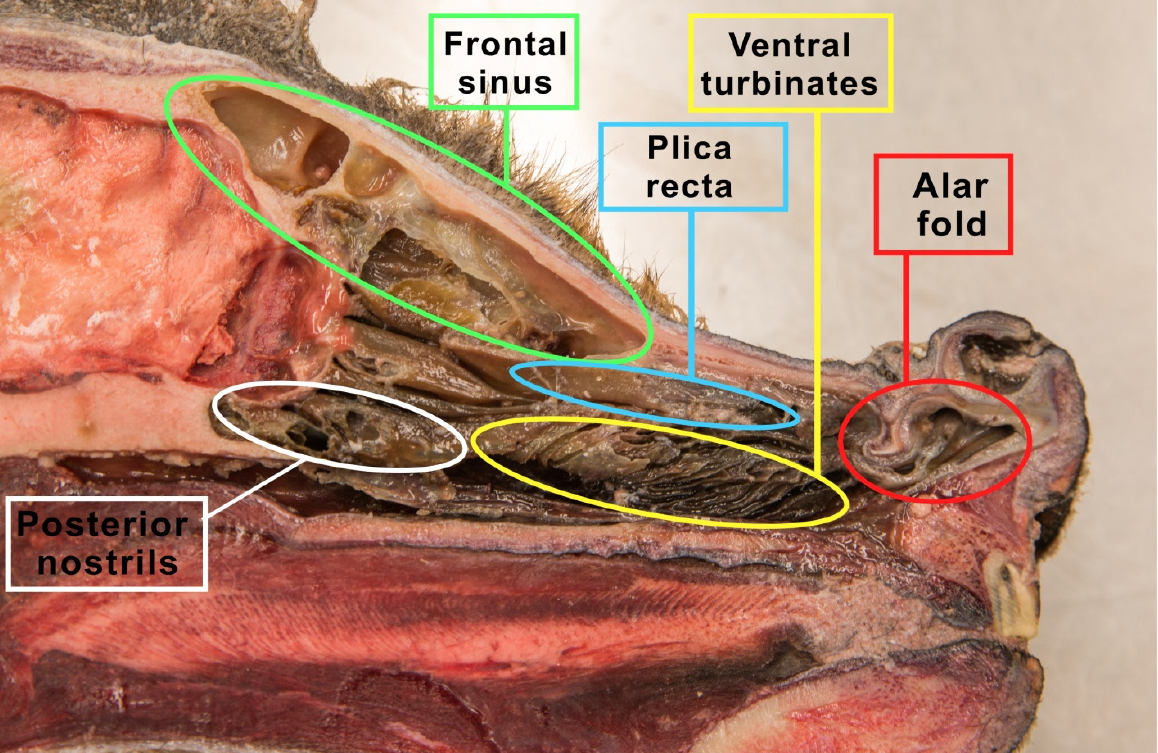
Figure 2. The figure shows a sagittal section of the wolf’s head. The nasal turbinates, the ethmoid labyrinth (made of the inner and outer ethmoid turbinate), nasal passages and the frontal sinus were prepared.